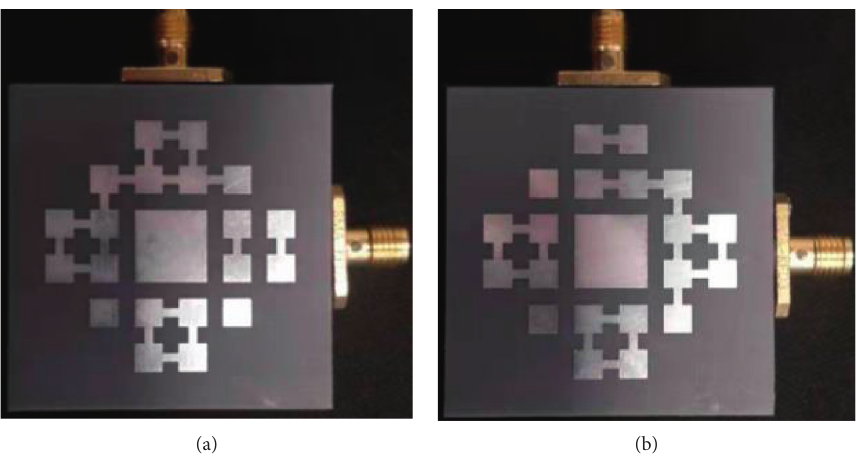
Figure 15: The fabricated RPA prototype. (a) θ xoz � 25 ° . (b) θ xoz � 45 ° .